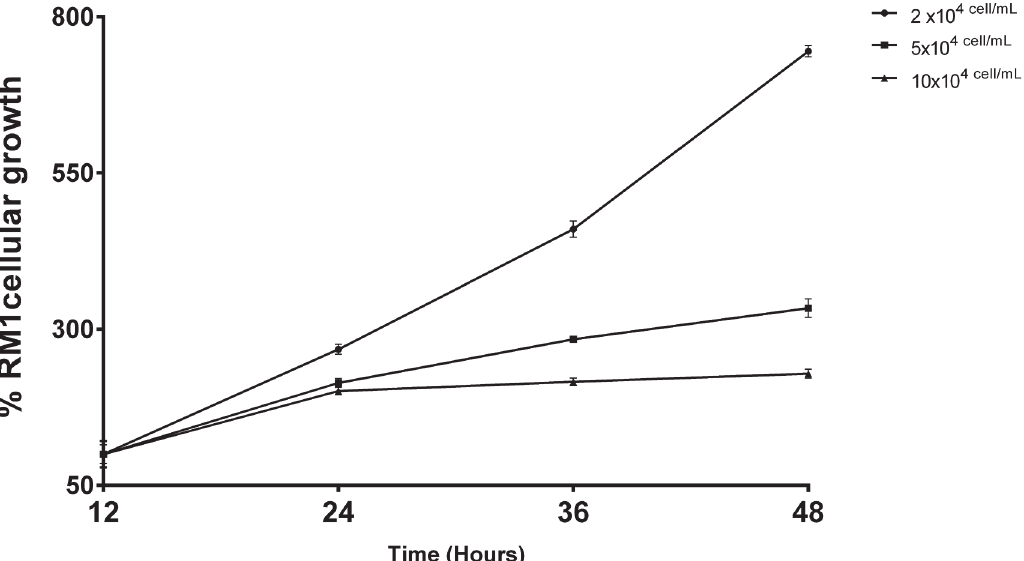
Fig 1. RM1 cell growth curve. Growth curve using three different initial cell concentrations (2x10 4 , 5x10 4 , 10x10 4 cells/mL) evaluated by the determination of the percentage of tetrazolium salt reduction at different time points (12, 24, 36 and 48h).